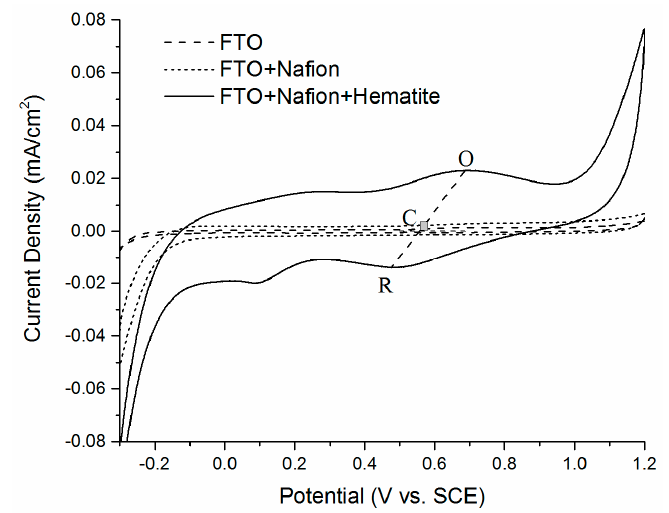
Figure 6. Cyclic voltammograms of natural hematite-FTO (Fluorine-doped tin oxide) and FTO electrodes. The solution was 1.0 M KCl and air saturated, pH 5.9 ± 0.1. Cyclic voltammetry (CV) scanned from − 0.3 to 1.2 V vs. SCE with a scanning rate of 20 mV · s − 1 .